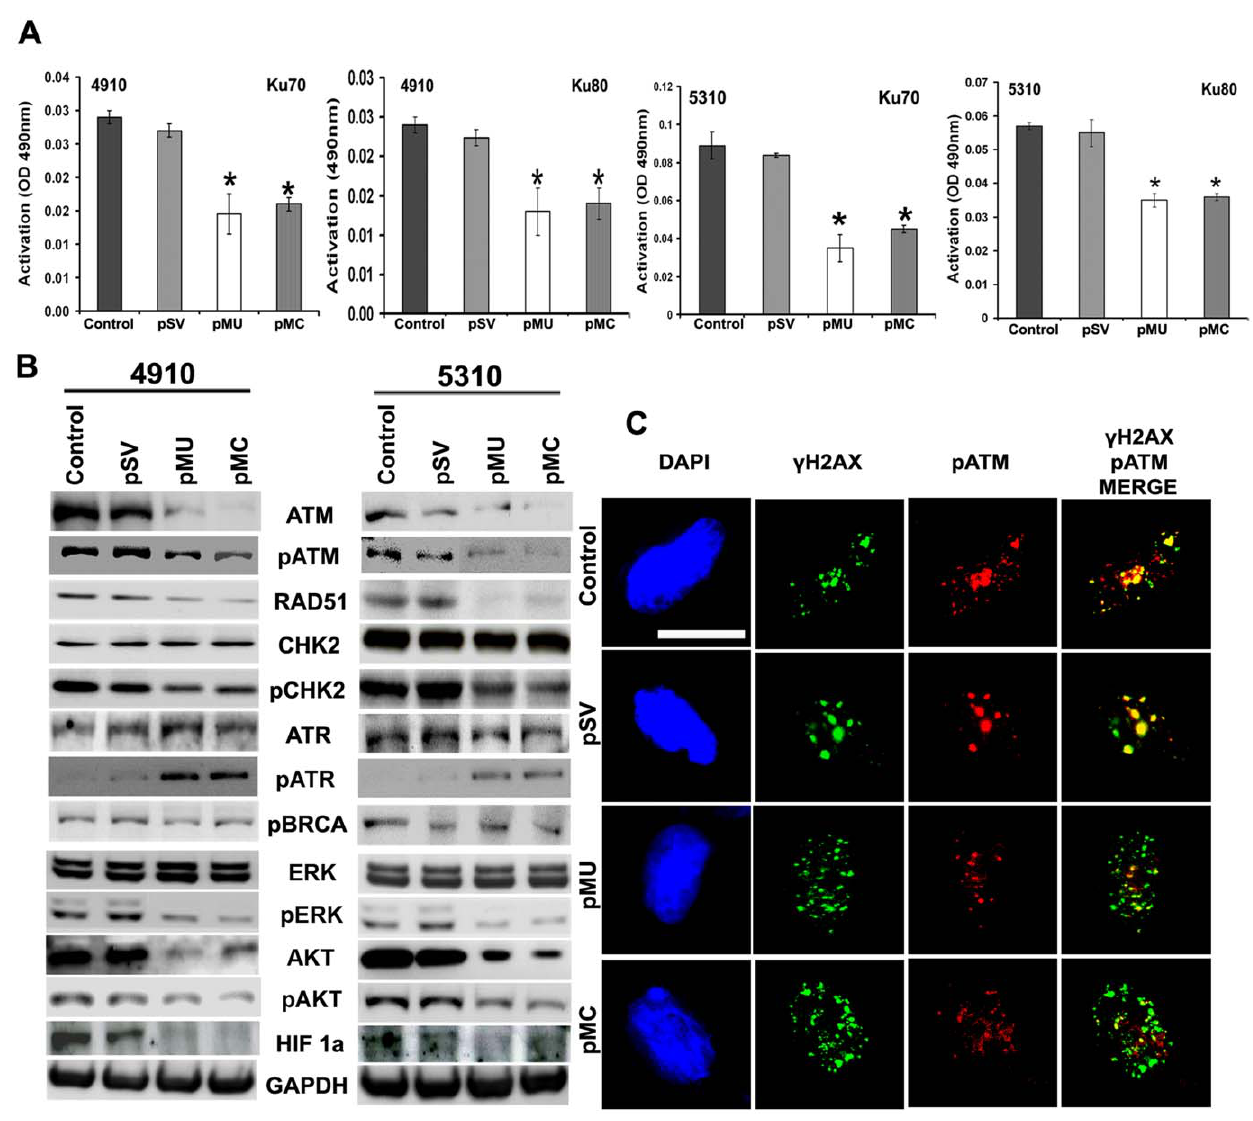
Figure 3. Inhibition of Ku activity and DDR related protein expression by pMU- and pMC-treated glioma xenograft cells. A. Ku70/80 DNA repair protein assay performed by using Active motif kit shows Ku70 and Ku80 protein binding to oligonucleotide in pMU- and pMC- treated 4910 and 5310 glioma xenograft cells along with control and pSV, respectively. Error bars indicate 6 SD. * significant at p , 0.05 Vs control. B. Immunoblot analysis showsexpression of key proteins involved in homologous recombination and DNA repair, such as ATM, pATM, RAD51, CHK2, pCHK2, ATR, pATR and pBRCA in both 4910 and 5310 glioma cells treated with pMU and pMC. Survival pathway protein such as ERK, pERK AKT and pAKT were analyzed using Western blot in pMU- and pMC-treated 4910 and 5310 glioma xenograft cells. Hypoxia assoaciated, HIF-1 a expression was analyzed in both cell types after pMU and pMC treatments. GAPDH shows equal loading. C. Immunocytochemistry analysis was carried out to show co-localization of pATM and c H2AX foci in pMU- and pMC-treated 5310 glioma xenograft cells along with control and pSV. pATM expression can be visualized as red dots and c H2AX foci as green spots. Merged image shows co-localization as yellow to orange spots. Magnification 60 6 , Bar=10 m m. Each experiment was repeated 3